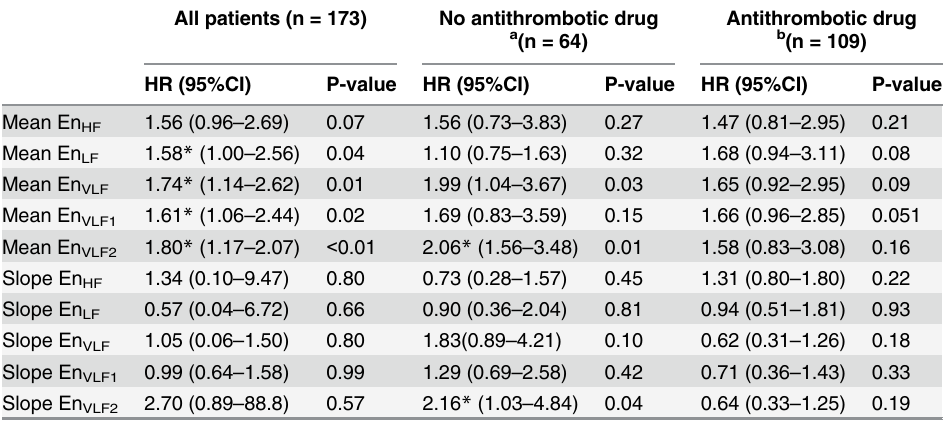
Table 5. Cox proportional hazards regression